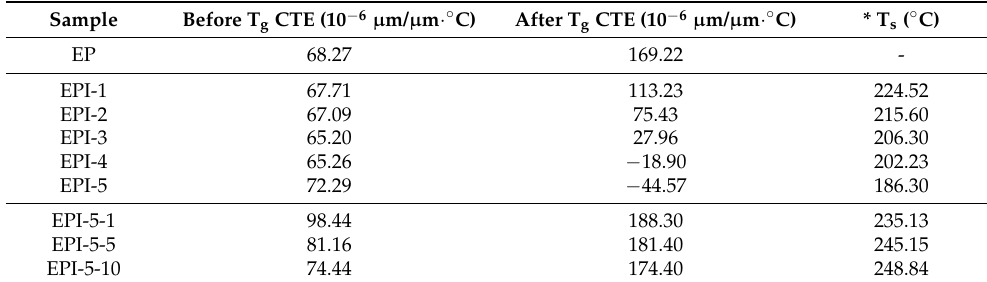
Figure 4. Thermomechanical analysis (TMA) thermograms of cured epoxy/polyimide blends ana- lyzed in N 2 gas atmosphere; ( a ) cured EPI and ( b ) postcured EPI. Table 3. Thermal expansion coefficient of cured epoxy/polyimide blends by thermomechanical analysis (TMA) in N 2 gas atmosphere.